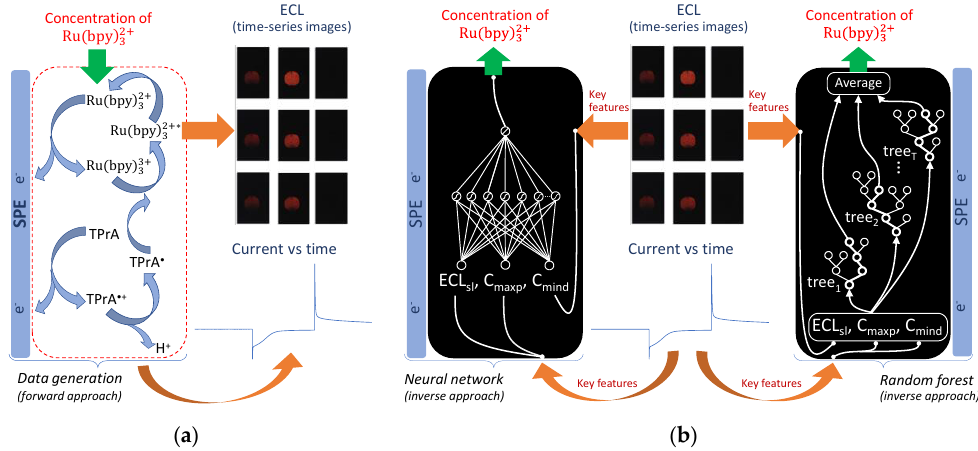
Figure 3. Schematic diagrams of ( a ) the procedure for experimental data generation (forward approach) using the mobile phone-based ECL sensor and ( b ) data-driven modeling (inverse approach) using a feedforward neural network and a random forest.